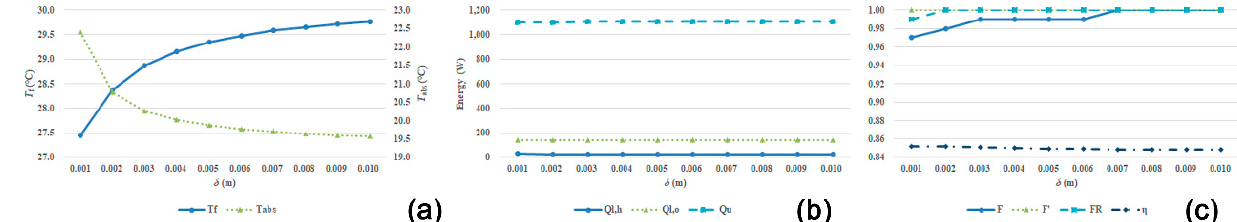
Figure 14. Influence of δ . ( a ) Dependence between T f , T abs , and δ . ( b ) Dependence between energy, and δ . ( c ) Dependence between efficiency parameters, and δ .